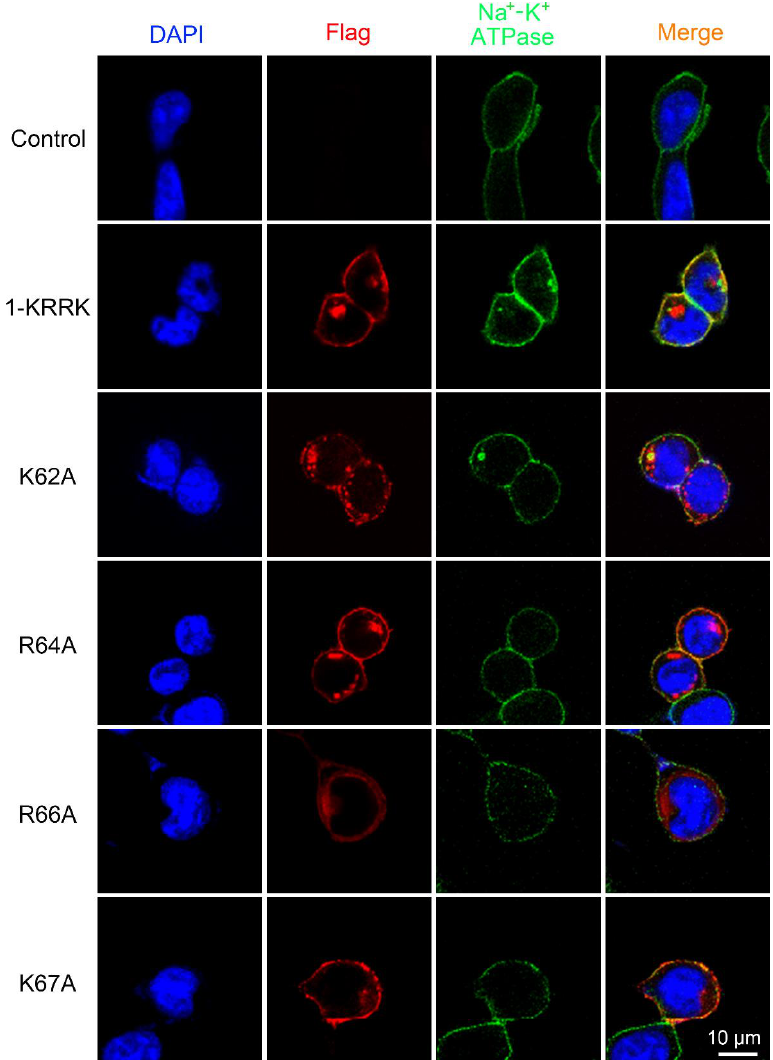
Figure 5. The colocalization analysis of IFITM1 mutants and Na + –K + ATPase in HEK293T cells. pcDNA3.1 and pcDNA3.1-Flag-1-KRRK/K62A/R64A/R66A/K67A were transfected in HEK293T cells, respectively. After 24 h, cells were stained with anti-Flag antibody, anti-Na + –K + ATPase antibody and DAPI. Then, cells were observed using confocal microscopy. IFITM1 mutants, red; Na + –K + ATPase, green; DAPI, blue.